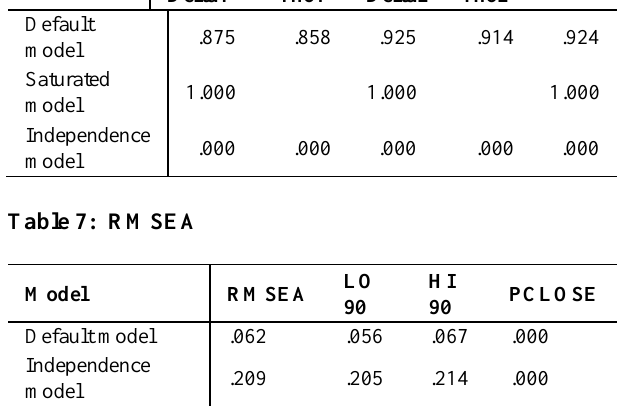
Table 4: Consistency